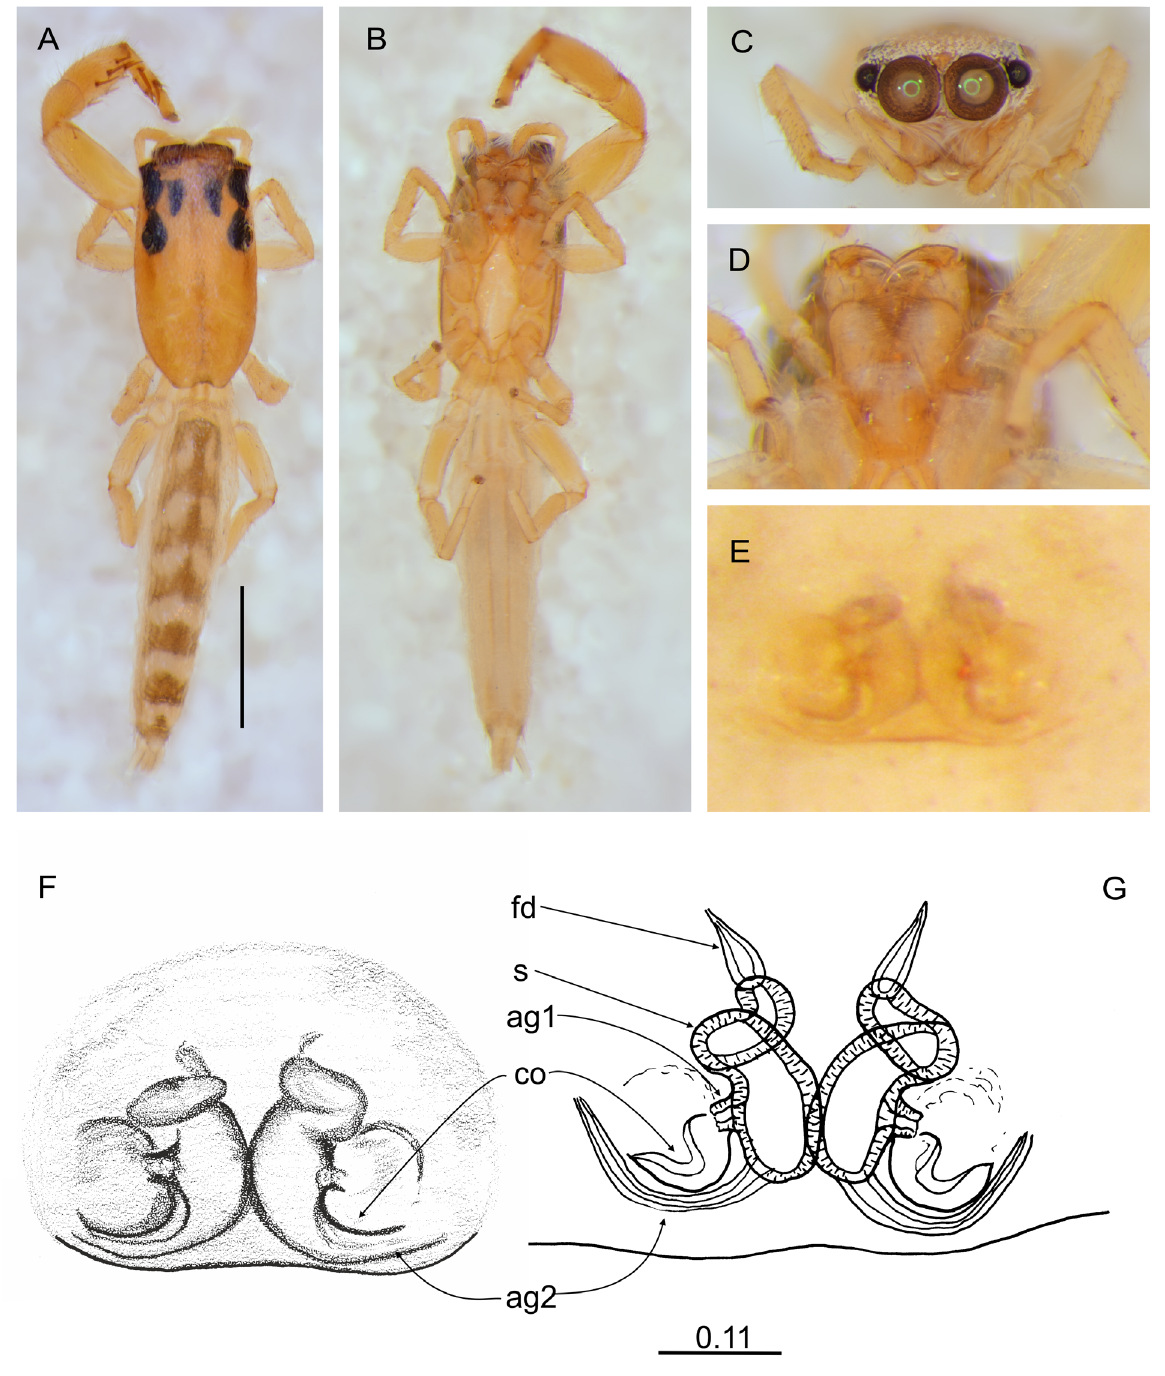
Fig. 7. Corambis logunovi sp. nov., paratype, ♀ (HNHM). A–C . Dorsal, ventral and frontal views. D . Chelicerae, maxillae and labium. E–F . Epigyne. G . Internal genitalia. Scale bar: A = 1